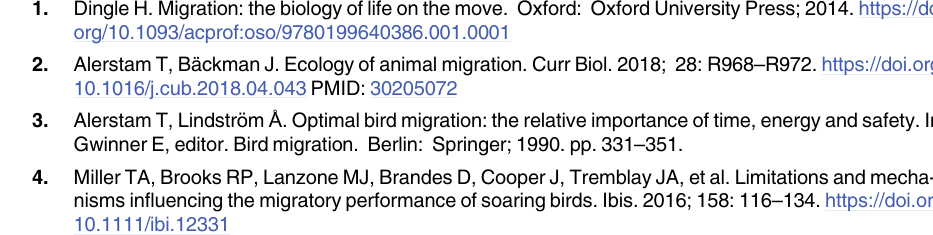
S3 Table. Consumption rate (prey consumed/min; mean ± SE) and energy intake (J/min;) of main dunlin prey consumed during spring and autumn migration at the Tagus estuary. Energy intake rates in autumn were estimated from one subset of videos (31 from 107) where all prey could be identified to species level. All data from spring was obtained from Martins et al. [52]. S1 Fig. Carbon and nitrogen stable isotope signatures in toenails of dunlins sampled at the Tagus estuary during spring migration. The wintering (non-breeding) origin of dunlins (Mauritania, Tagus estuary and unknown) was assessed following Catry et al. [43,